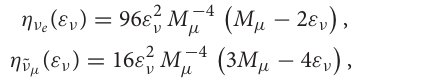
ν µ neutrino beams, ˜